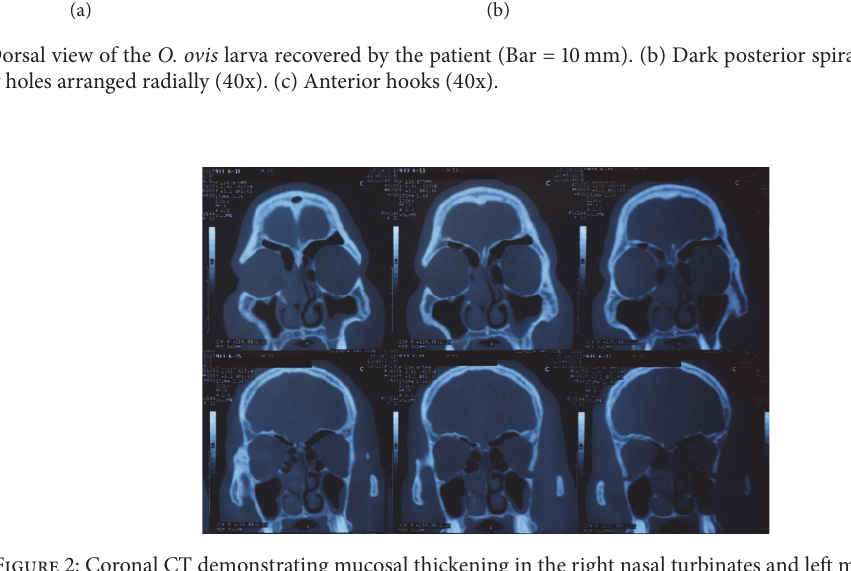
denied having fever, chills, headache, diplopia, blurred